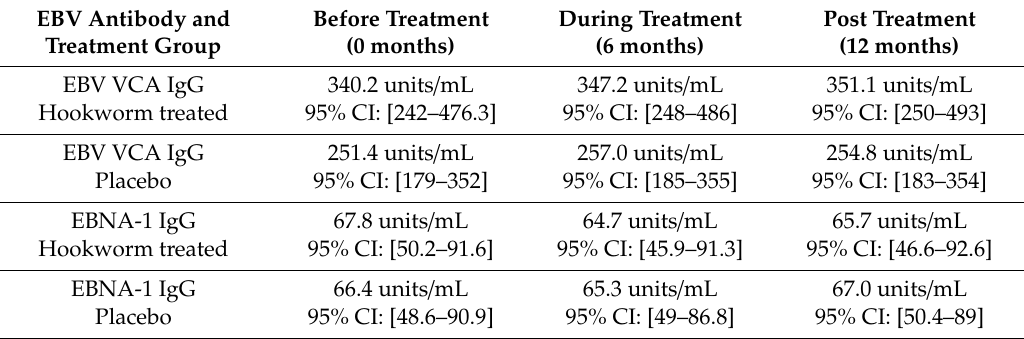
Table 2. EBV VCA and EBNA-1 geometric mean IgG levels in hookworm-treated ( n = 26) and placebo-controlled ( n = 25) PwMS before, during, and three months after treatment. EBV Antibody